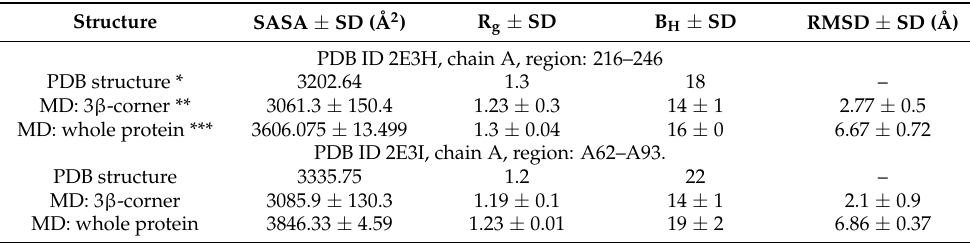
Table 1. Comparative analysis of the geometric characteristics of the 3 β -corner in a protein environ- ment and autonomously from protein in an aqueous medium (three technical